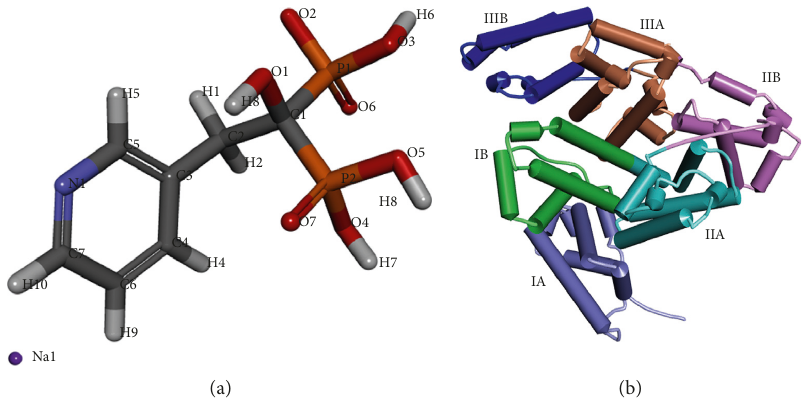
Figure 1: Discovery studio visualization of (a) 3D structure of RSN and (b) secondary structure of BSA. Each site is marked with different